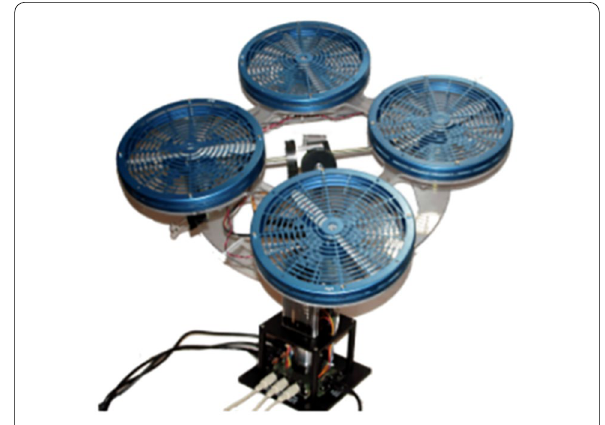
Figure 4 3-DOF hover simulation platform of the